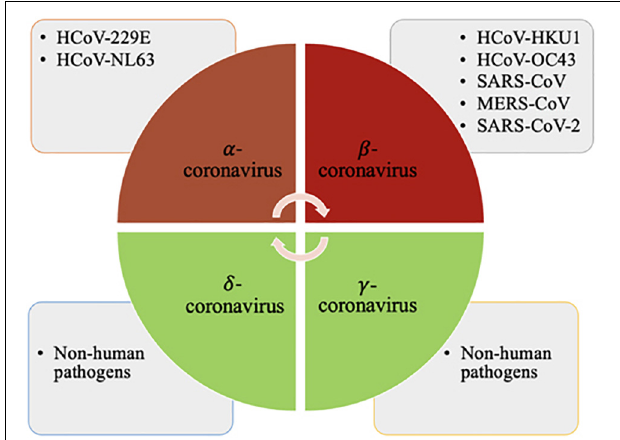
FIGURE 1 | The α -coronaviruses are HCoV-229E, HCoV-NL63; β -coronaviruses are HCoV-HKU1, HCoV-OC43, SARS-CoV, MERS-CoV and SARS-CoV-2; and the γ and δ -coronaviruses comprise species that are non-pathogenic to humans. Created with